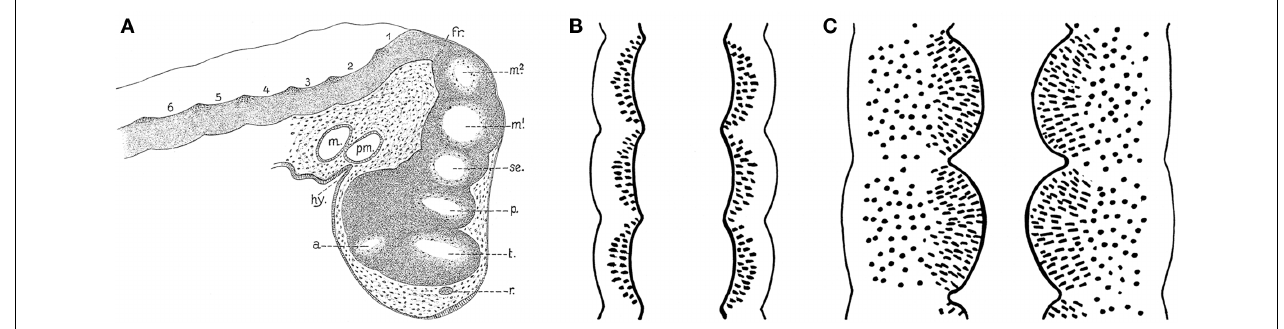
Reproduced fromVon Kupfer (1906). (B) Diagrammatic horizontal section through the neuraxis of an early embryo. Each neural segment or neuromere is separated from its neighbors by external vertical constrictions, which correspond to internal sharp dorsoventral ridges. (C) Similar section through the neuraxis of a later developmental stage, in which the neuromeres present themselves as distinct and sharply separated intraventricular